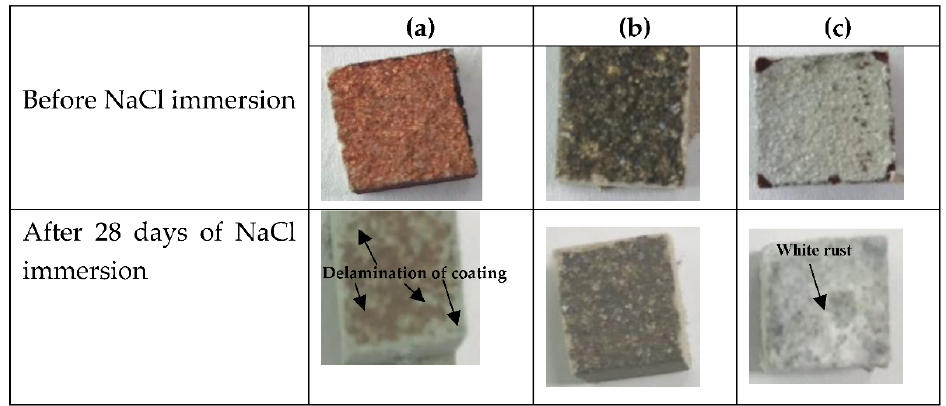
Figure 6. Digital images of ( a ) Cu, ( b ) Ti, and ( c ) 85Zn-15Al in 5% NaCl solution after 28 days of